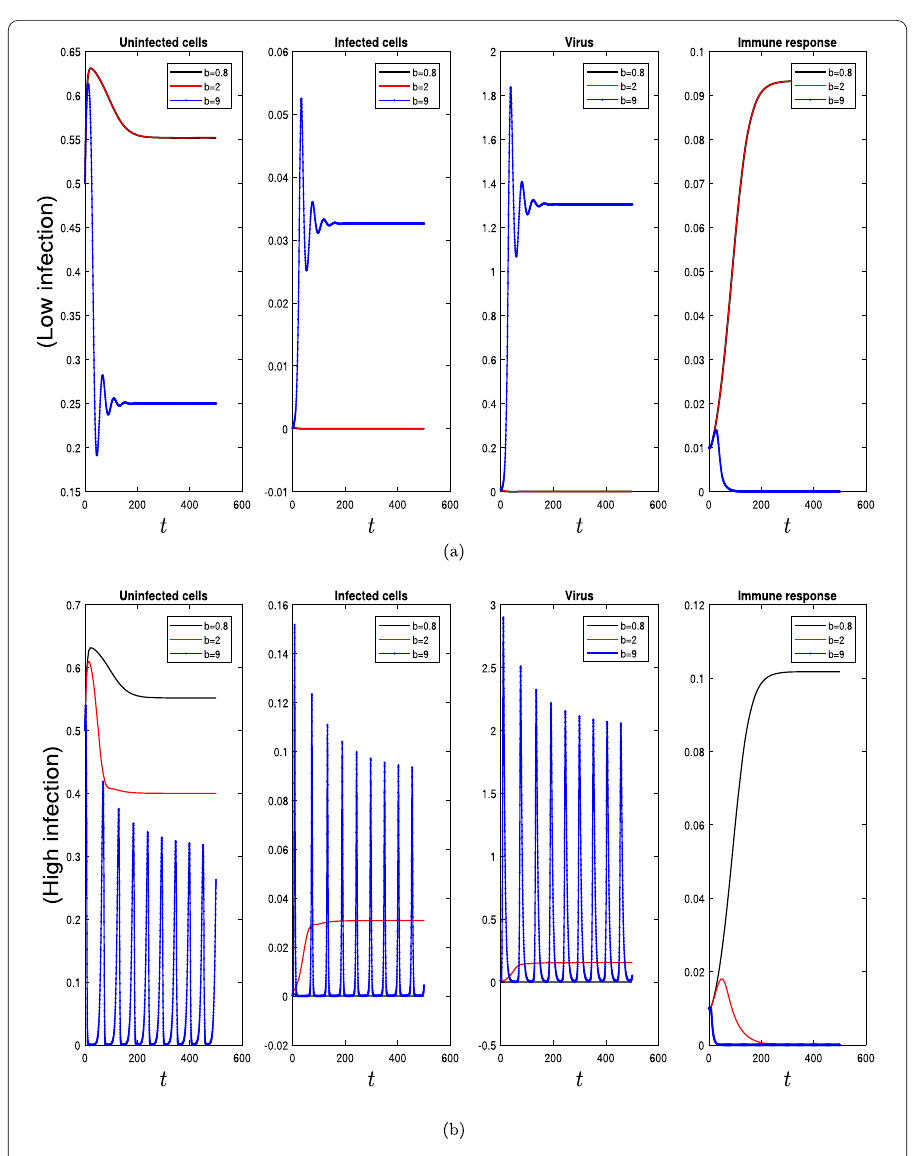
Figure 7 Numerical simulations of model (2) with initial values: x (0) = 0.5, y (0) = 0, v (0) = 0.01, and z (0) = 0.01, showing the time variation in each compartment of the model with varying values of b as shown in the legend (other parameters are set as in (11) except n = 0.16). The simulations are carried out for two cases of infection rate, ( a ) low infection ( a = 0.1) and ( b ) high infection ( a =